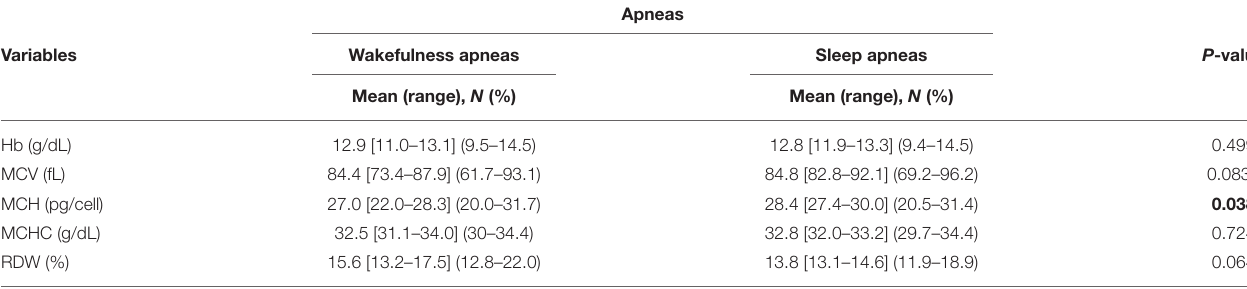
TABLE 8 | Red blood cell count variables in data of the examined patients with RTT as a function of wakefulness ( n = 17) vs. sleep apneas ( n = 49).